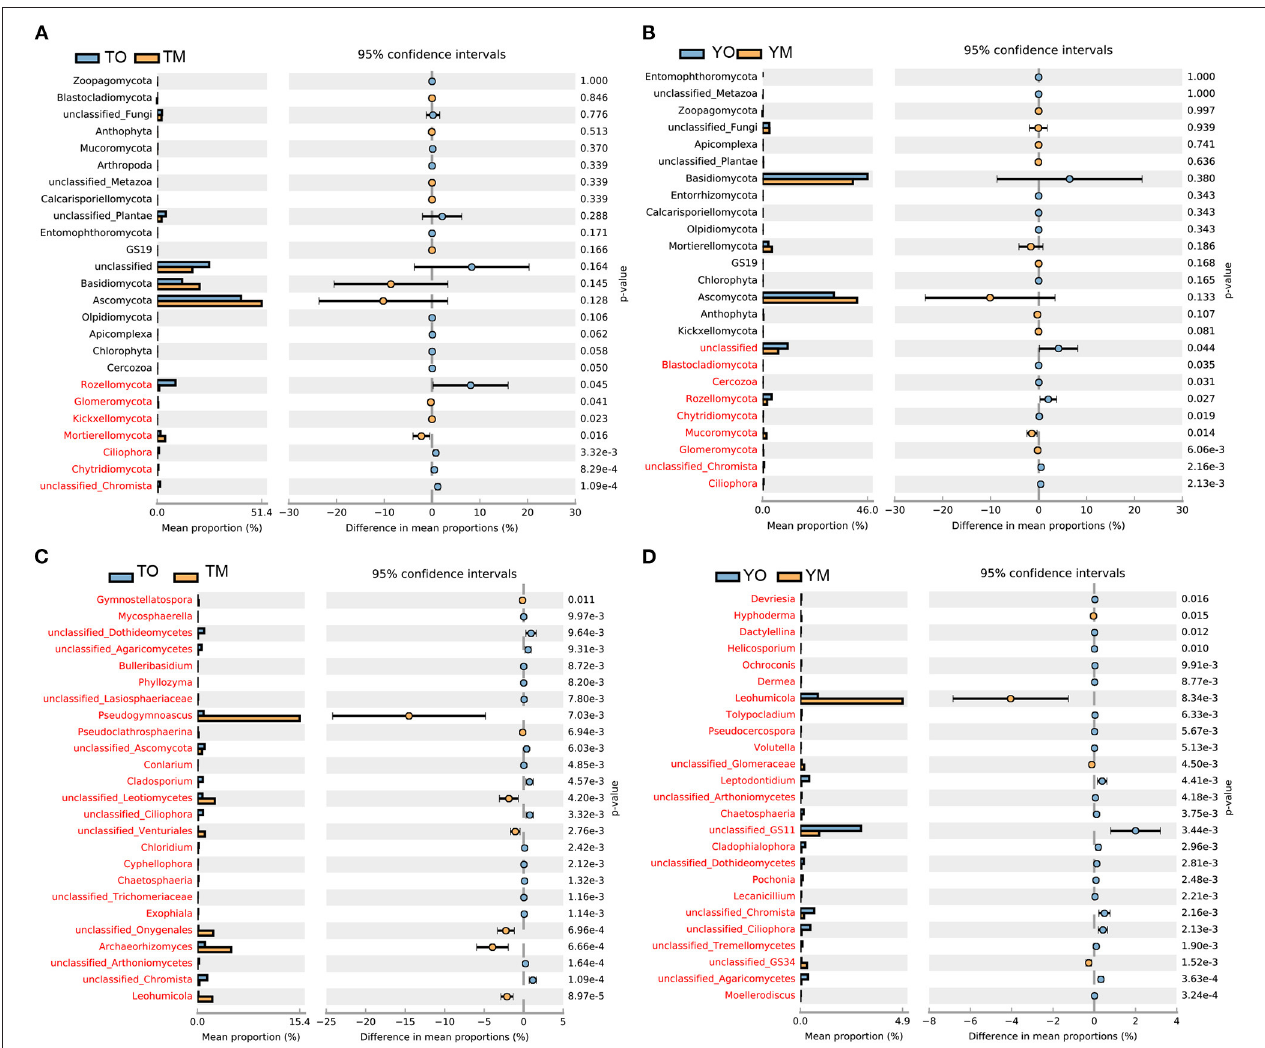
FIGURE 3 | Significantly altered fungal communities between the O and M horizon as measured by the response ratio method at the 95% confidence interval (Welch’s t -test). Fungal communities of the O and M horizon based on phylum level at Tiantangzhai Nature Reserve (A) and Yaoluoping Nature Reserve (B) , and fungal communities of the O and M horizon based on genus level at Tiantangzhai Nature Reserve (C) and Yaoluoping Nature Reserve (D)